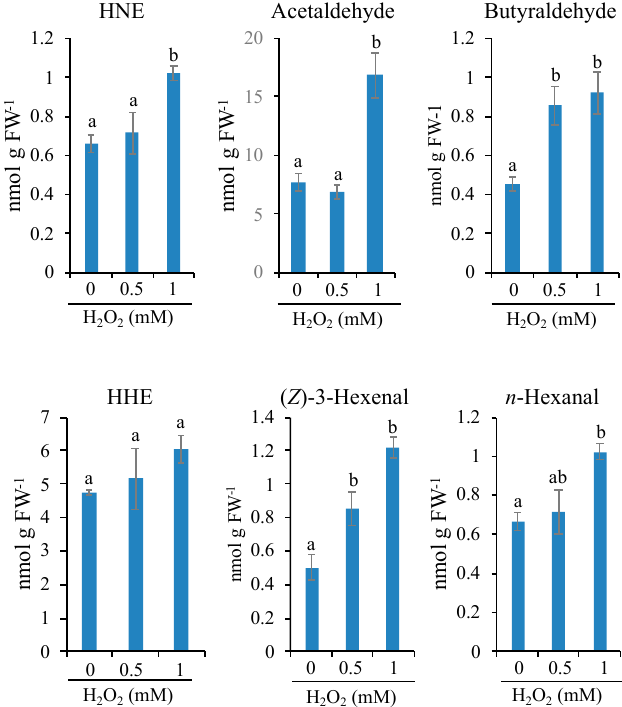
Figure 5. E ff ects of H 2 O 2 on the carbonyl levels in BY-2 cells. To 4-d-cultured cells, H 2 O 2 was added to the indicated concentration. After a 10-min incubation, cells were harvested, and the intracellular contents of carbonyl levels were determined as in the Materials and Methods section. Results of 4-hydroxy-( E )-2-nonenal (HNE), acetaldehyde, butyraldehyde, 4-hydroxy-( E )-hexenal (HHE), 3-(Z)-hexanal and n -hexanal are shown. Each point represents the mean of three independent experiments and the error bars the SEM. Di ff erent letters represent significantly di ff erent values ( p < 0.05 on Tukey test).